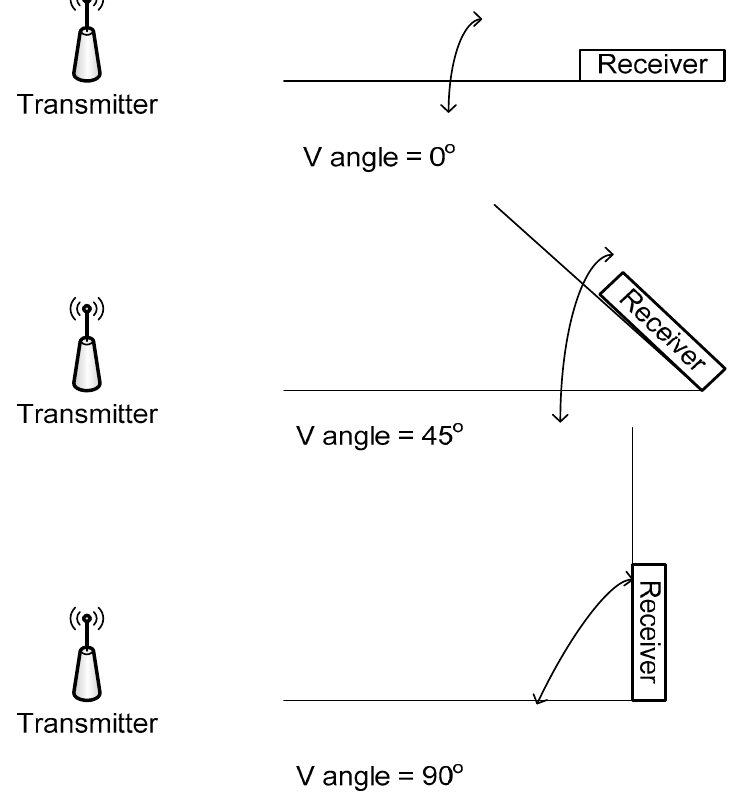
Figure 12. Angles of receiving station according to horizontal plane.